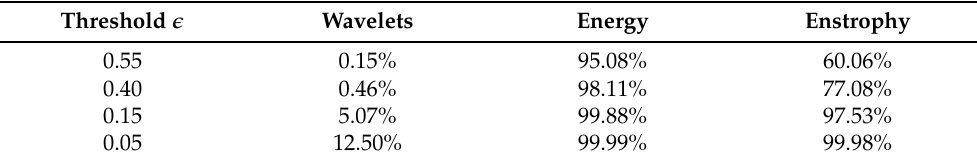
Table 1. Fraction of active wavelets and captured energy/enstrophy for different thresholding